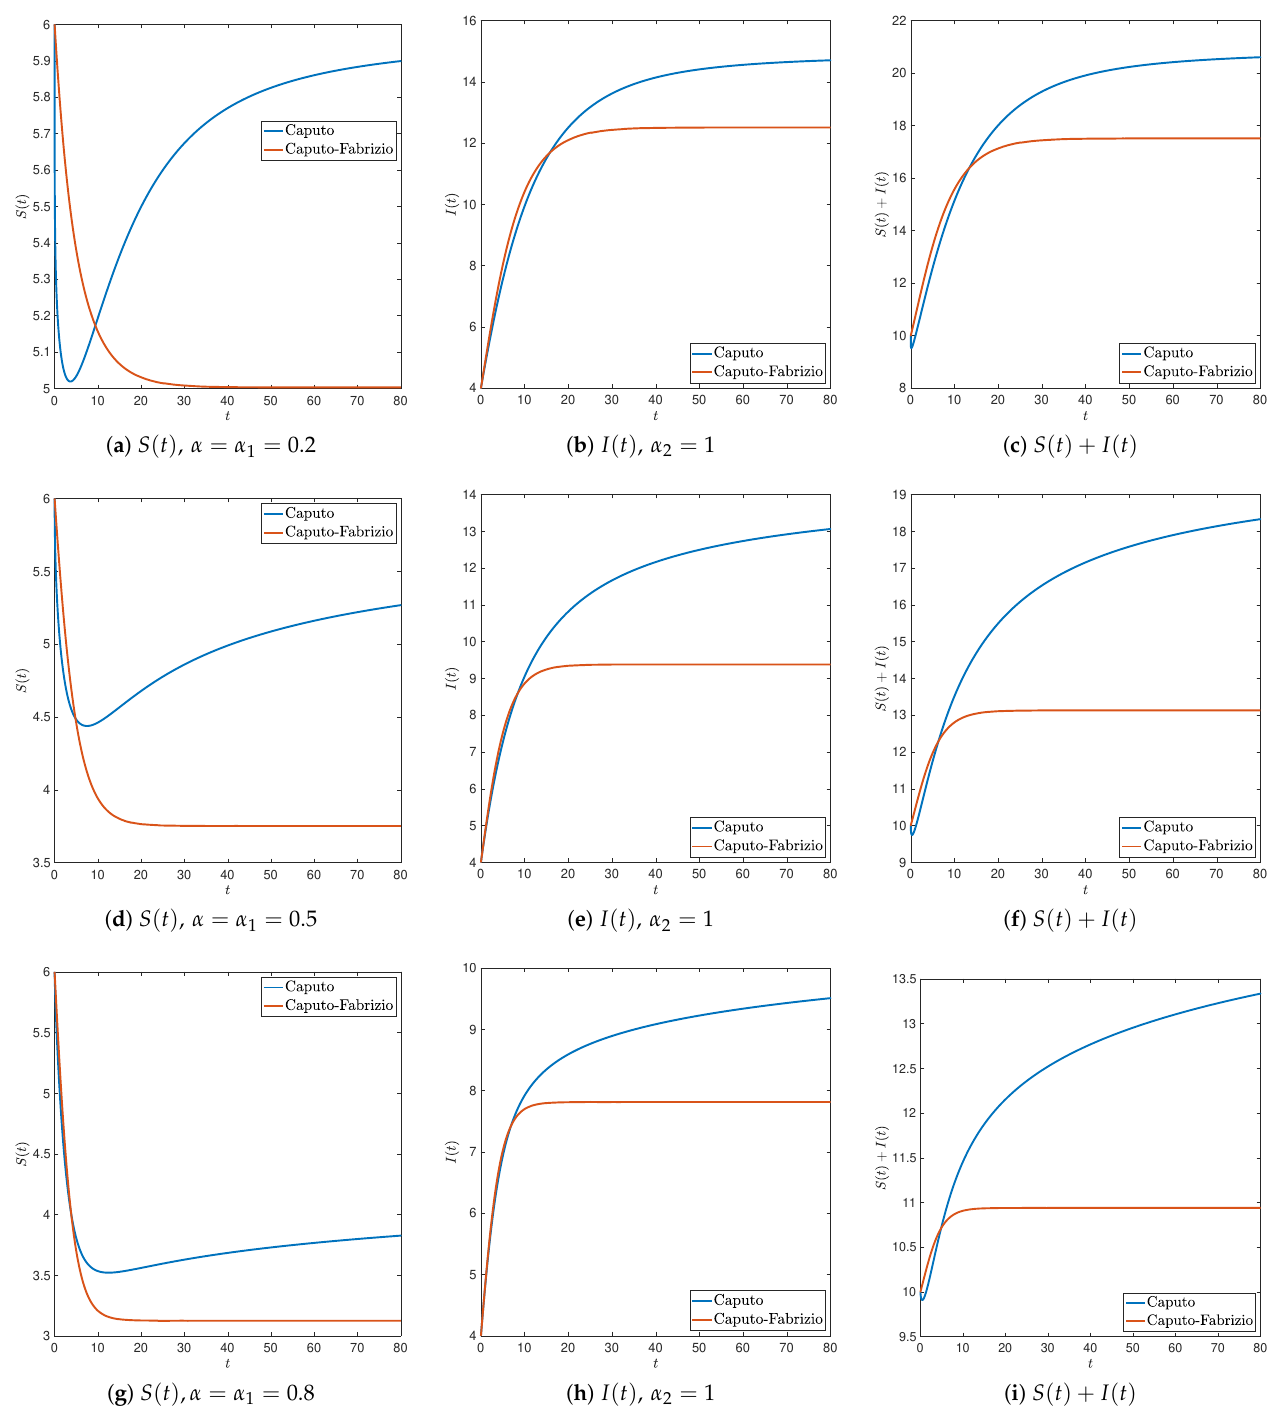
Figure 7. Numerical solutions to (1) and (2) for α = α 1 = 0.2 (top), α = α 1 = 0.5 (center), and α = α 1 = 0.8 (bottom) with α 2 = 1, β = 0.7, γ = 0.2, S 0 = 6, I 0 = 4 and M ( α ) ≡